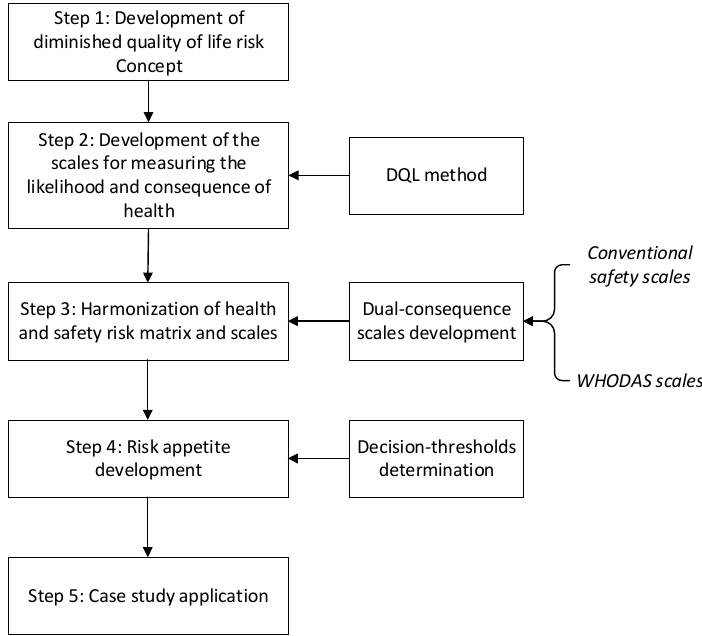
Figure 1. Research workflow of the development of H&S risk harmonization.